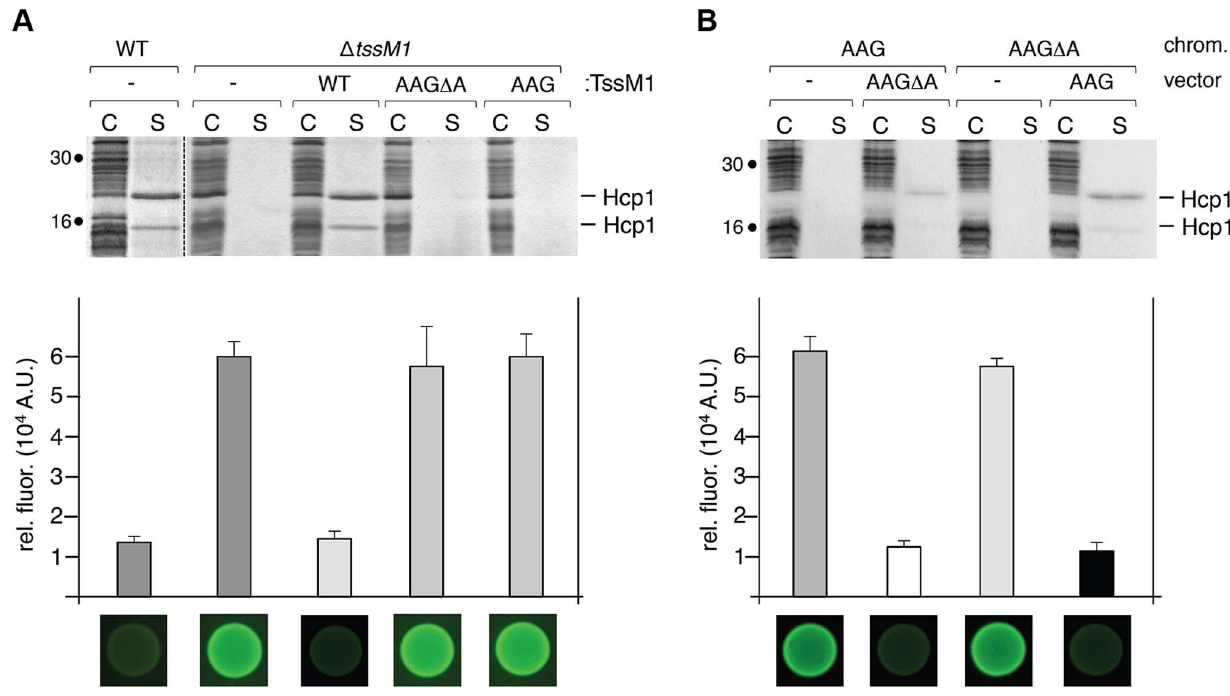
Figure 4. Both TssM1 size variants are required for activity of the CTS1 T6SS. (A) C. rodentium WT cells or D tssM1 cells expressing WT tssM1 (WT; producing both forms of TssM1: TssM1-FL and TssM1[1–807]) or TssM1 variants bearing mutations in the poly-A tract (AAG; producing only the TssM1[1–807] variant) or mutations in the poly-A tract and a deletion of the last nucleotide (AAG D A; producing only the TssM1-FL variant). (B) C. rodentium cells producing the AAG D A and AAG variants from the chromosome and producing the other variant from the pBAD18 vector. Hcp release assay (top panels). The extracellular proteins were isolated by separating whole cells (C) and the supernatant fraction (S). Proteins were visualized by Coomassie blue staining after 15%-acrylamide SDS-PAGE. Molecular mass markers are indicated on the left. Growth competition assay (bottom panels). Growth competition assay was monitored by mixing fluorescently labeled GFP + E. coli W3110 prey cells with the indicated strains of C. rodentium as predators. Mixes were spotted onto LB agar supplemented with IPTG (500 m M) and arabinose (2%), and incubated for 14 h at 30 u C. The relative fluorescence (upper graph) is expressed in arbitrary units (A.U.) and is the mean of fluorescence levels obtained from three independent experiments (each measured in triplicate). Fluorescent images of the competition assays (obtained with a LI-COR Odyssey imager) are shown below the upper graph.